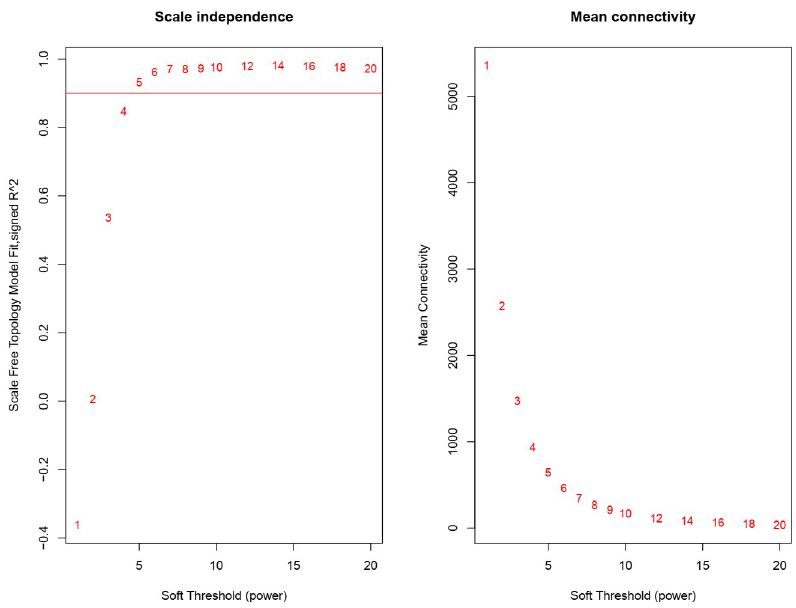
Fig 1. Analysis of soft-thresholding power in the WGCNA. The left picture displays determination of scale-free fit index (y-axis) for various soft-thresholding powers. The right picture shows determination of mean connectivity (degree, y-axis) for various soft-thresholding powers